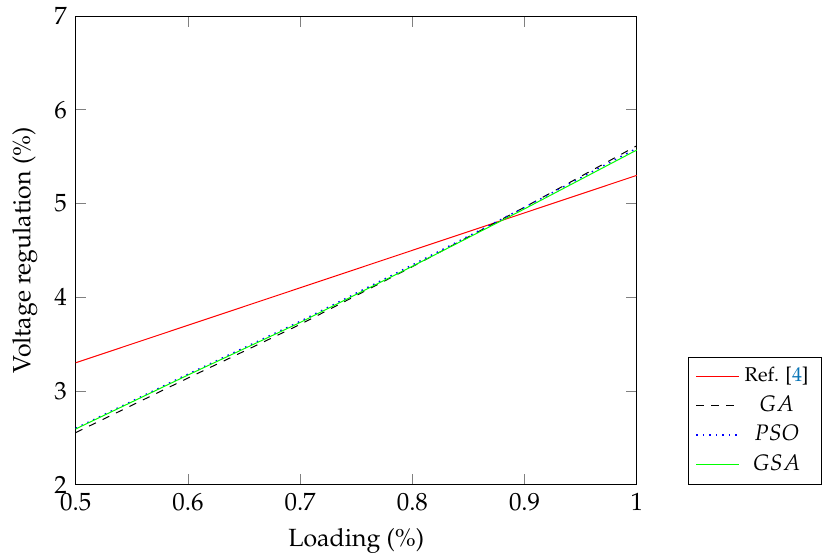
Figure 4. Voltage regulation by varying the load on the 4 kVA single-phase